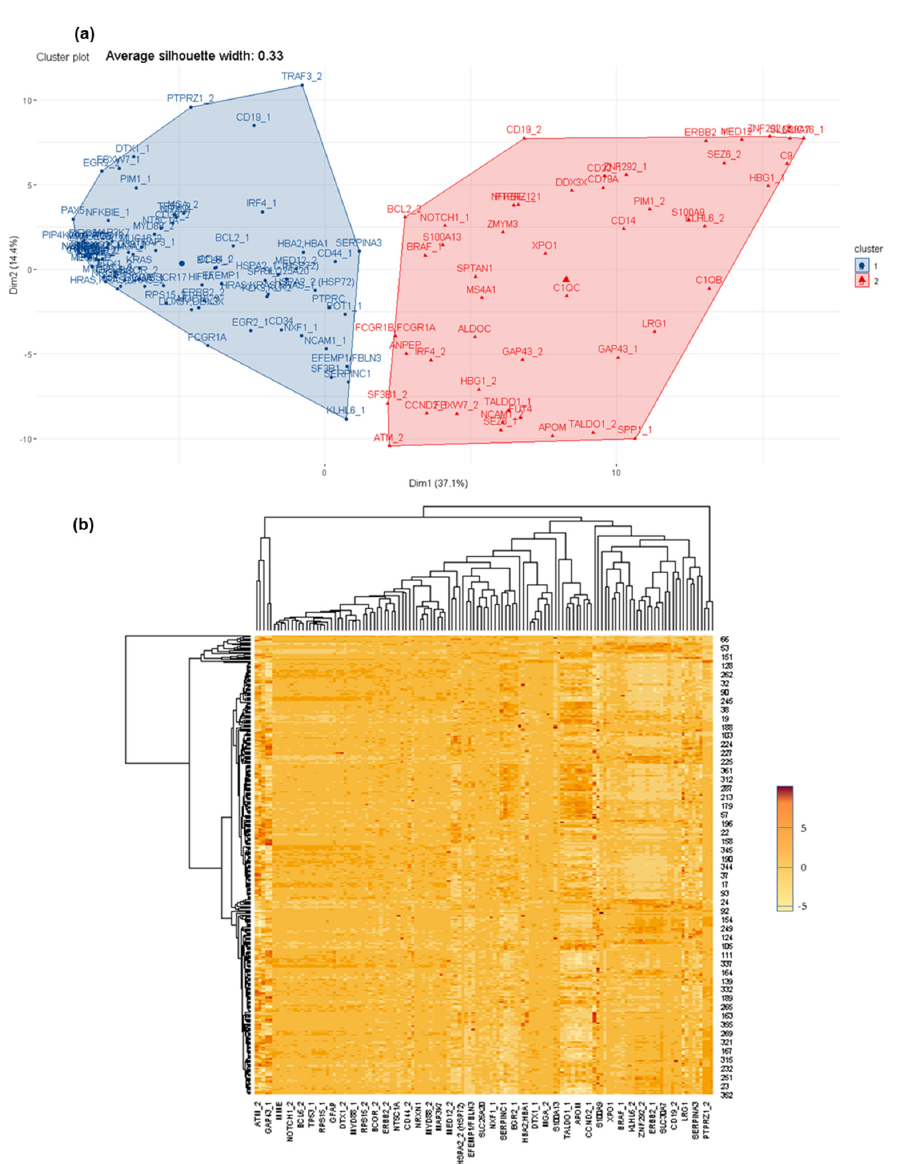
Figure 4. Differential protein profiles between CSF +/ − LM by affinity proteomics. ( a ) Differential protein profiles clustered to discriminate between CSF +/ − LM. ( b ) Heat map of protein distribution determined in this comparison.